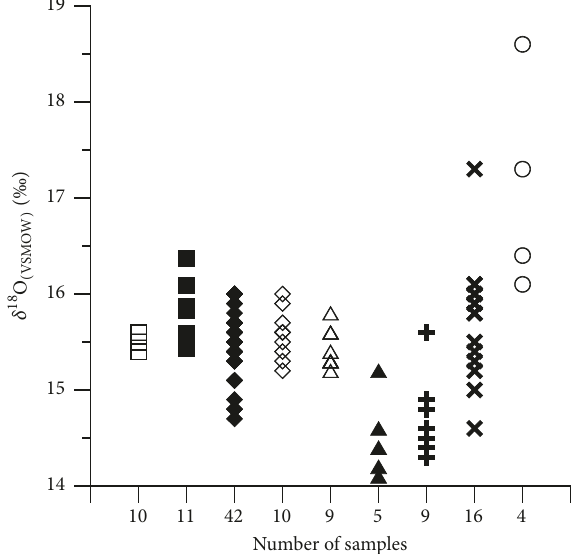
Figure 2: Comparisons among 𝛿 18 O ( values of natron glass VSMOW ) samples [open symbols: Thessaloniki Agora ( ◻ ); Maroneia ( ⬦ ); Thessaloniki, various sites ( 󳵻 ); Thessaloniki glass with moderate 18 O enrichment ( I )] and those already reported in the literature [full symbols: Roman glass from Europe ( ◼ ) [2]; Roman glass from Iulia Felix ( X ) [3]; 4th century AD glass from Jalame ( 󳵳 ) [2]; HIMT glass from Carthage and Levantine natron glass (bold plus sign) [12]; late Antique-early Medieval glass from Grado ad Vicenza (bold multiplication sign) [3]]. Number of analysed samples is also